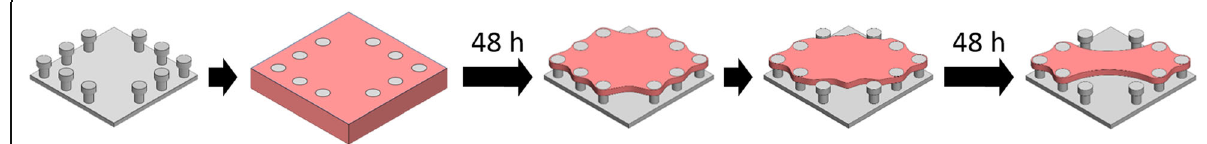
Fig. 1 Schematic overview of the experimental procedure in the micro-tissue platform. To the array of micro posts (grey), a suspension of cells and collagen (pink) was added. Cells contracting and applying force to their collagenous environment results in formation of a predominantly isotropic micro-tissue around the constraining posts in the subsequent 48 h. By releasing the tissue constraints of the four outermost posts, a